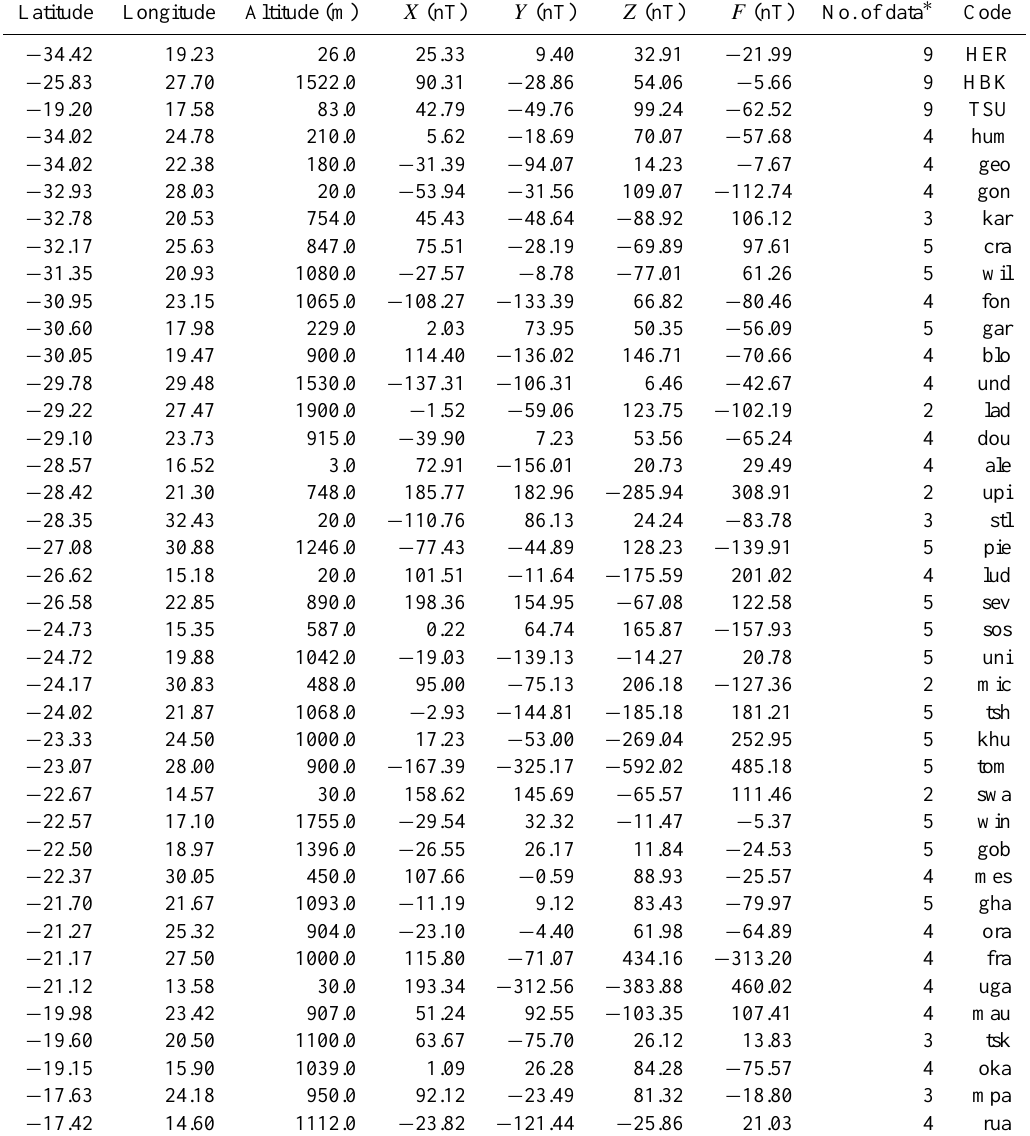
Table 3. Observatory and repeat station lithospheric anomaly values for the southern African region with magnetospheric correction. Latitude Longitude Altitude